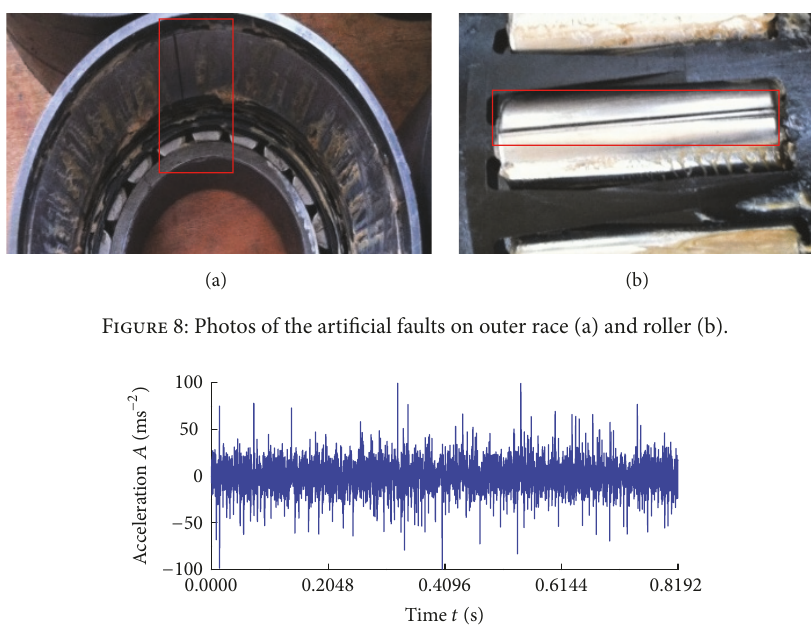
Figure 9: Measured vibration signals of bearing outer race